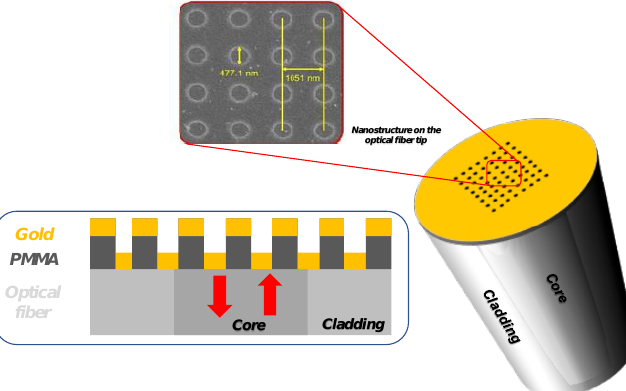
Figure 34. Cross section view and SEM image of the LOF resonator realized on the optical fiber tip. Adapted with permission from Ref. [159] (the figure is released under a Creative Commons CC BY license http://creativecommons.org/licenses/by/4.0/ (accessed on 12 March 2023), Copyright © 2018).